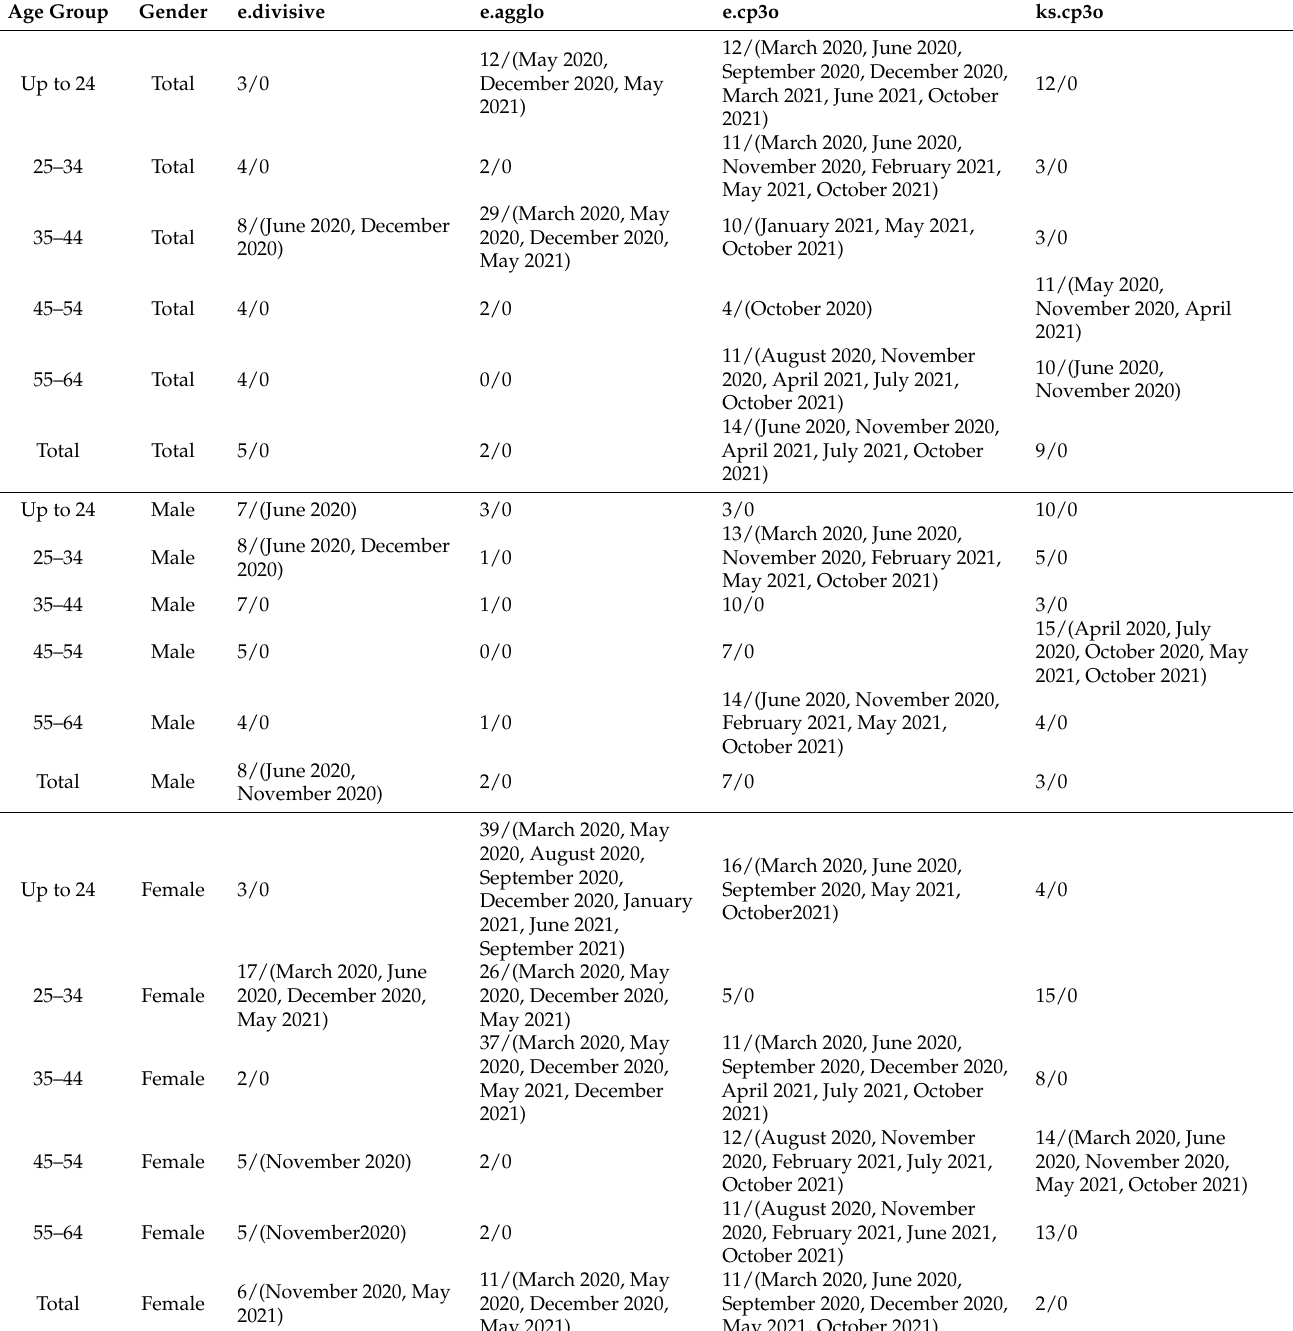
Table A2. Nonparametric multiple change point detection in time